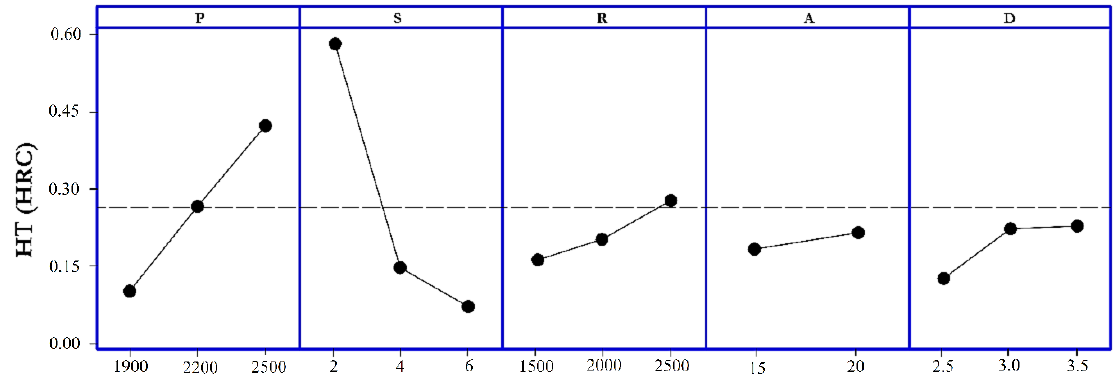
Figure 4. Effects of process parameters on the case depth at the tip of the spline’s tooth ( H T ). The unit of parameters are laser power (P) in [W] scanning speed (S) in [mm/s], rotational speed (R) in [rpm], flank tilt angle (A) in degrees, and tooth depth (D) in [mm].